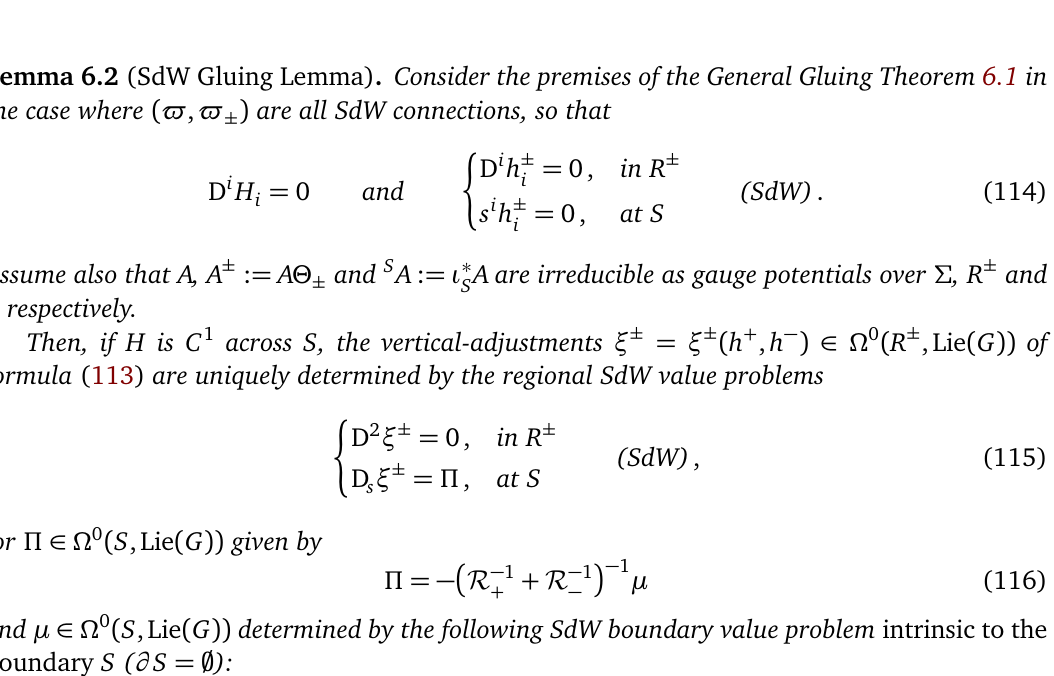
Figure 6: The two subregions of Σ , i.e. Σ ± , with the respective horizontal perturba- tions h ± on each side, along with the separating surface S